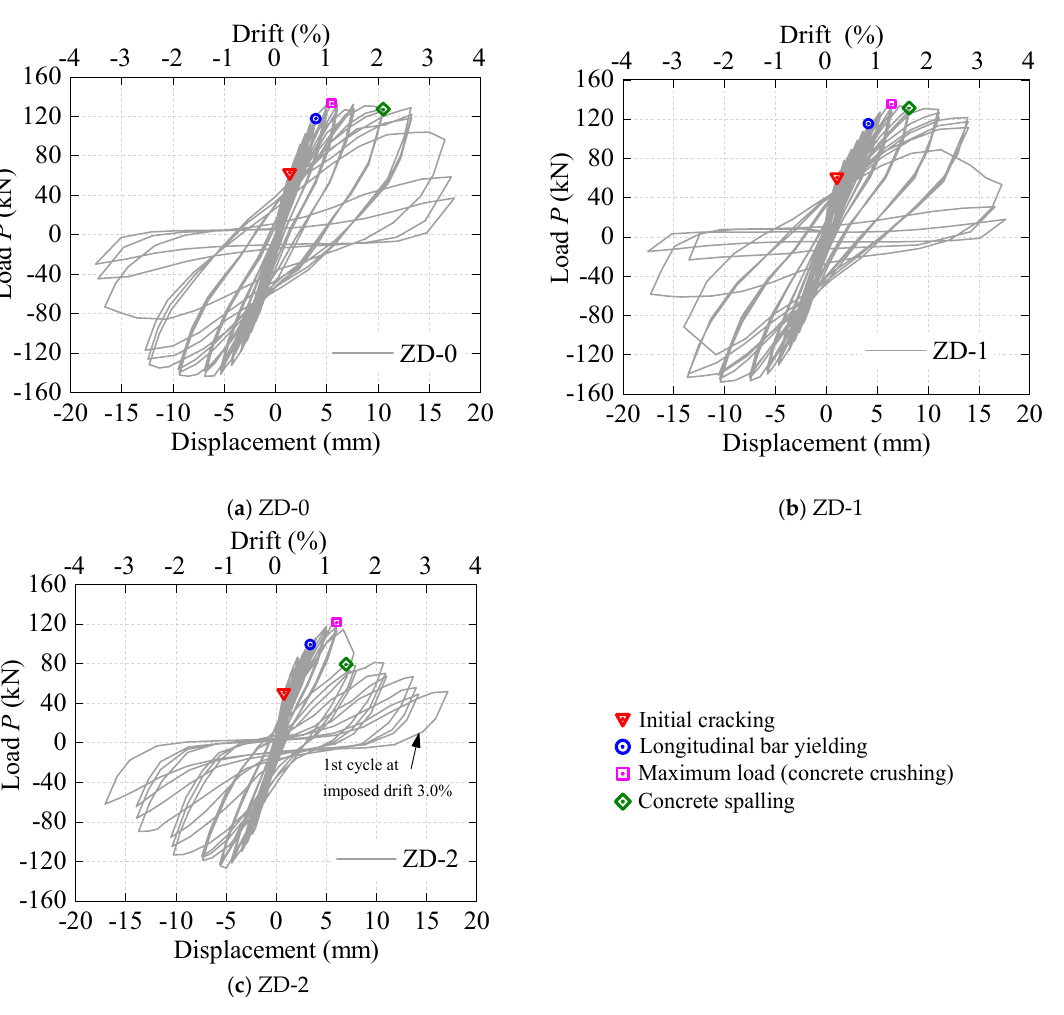
Figure 8. Force-displacement responses.